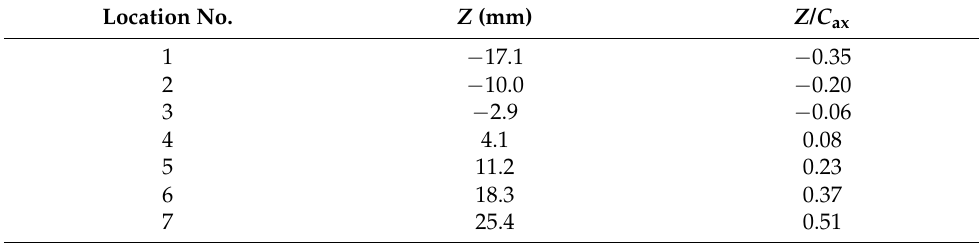
Table 2. Plasma actuator